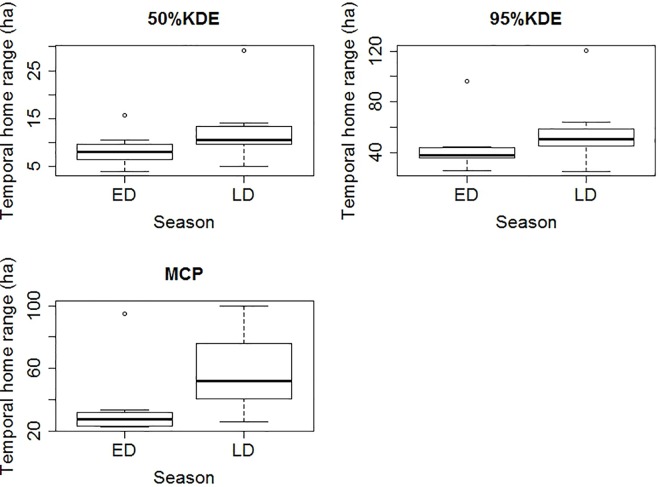
Box plot for temporal home ranges of BTF in early dry season (ED) and late dry season (LD) calculated for: 50% kde, 95%kde and MCP.